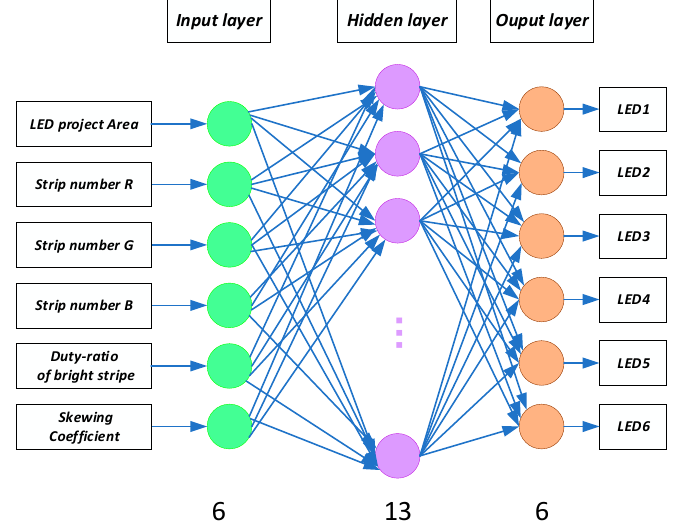
Figure 14. BP network structure of LED-ID classification and recognition.